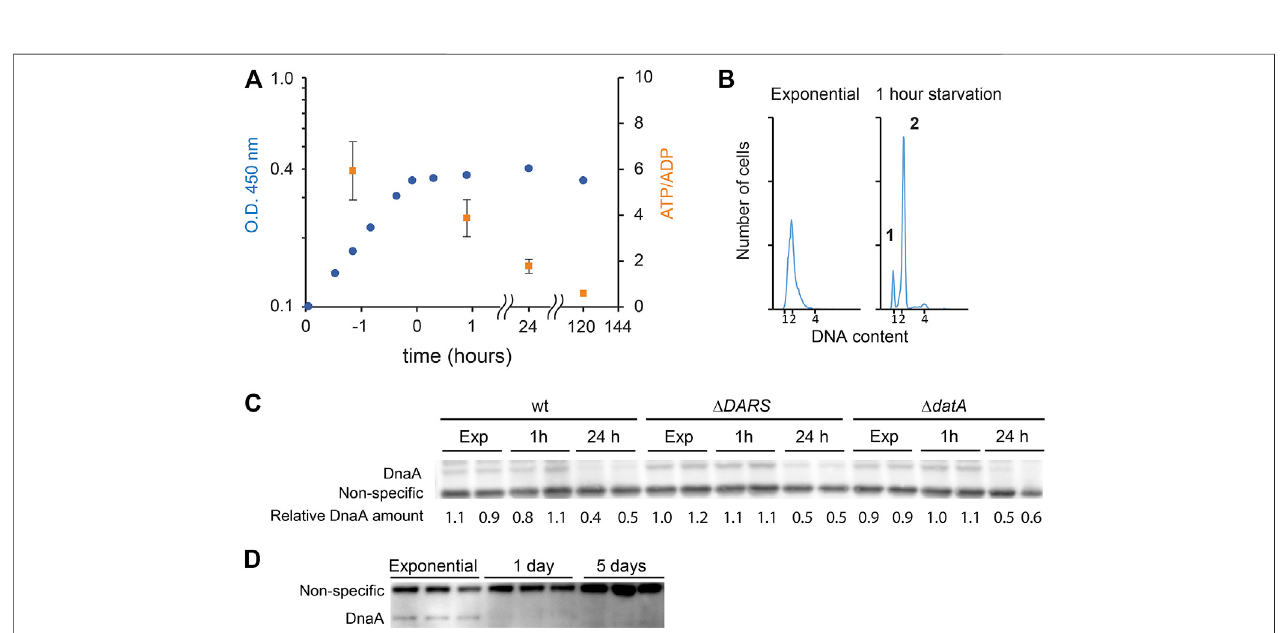
FIGURE 4 | DnaA stability during carbon starvation. (A) Growth curve of MG1655 grown at 37 ° C in minimal medium supplemented with 0.02% glucose. Cells reached a plateau at O.D. 450 nm (cid:2) ∼ 0.4. Time points where ATP/ADP was measured are shown as orange squares (SD +/ − (n (cid:2) 3)). (B) Flow cytometry analysis showing the DNA content of cells taken during exponential growth (third time point in panel 4A ), 1 h after glucose depletion (eighth time point in panel 4A ) showing cells with 1, 2, or 4 fully replicated chromosomes. (C) The DnaA protein level during exponential growth at 37 ° C in AB medium supplemented with 0.02% glucose and after 1 h or 1 day of carbon starvation in wild type, MG1655 Δ DARS1 Δ DARS2 , and MG1655 datA strains. (D) The DnaA protein level during exponential phase, 1 day, and 5 days after carbon starvation.